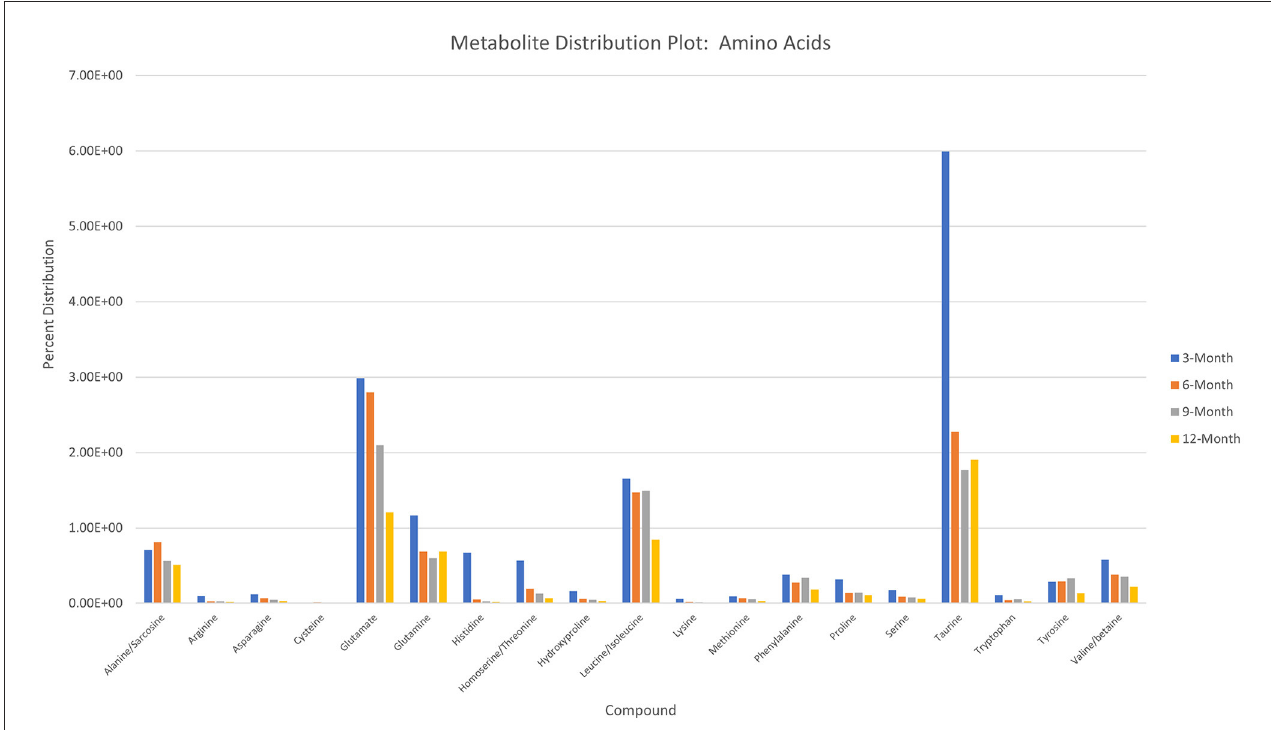
FIGURE9 Histogram depicting normalized metabolite abundances for essential, non-essential, and conditionally essential amino acids detected in all